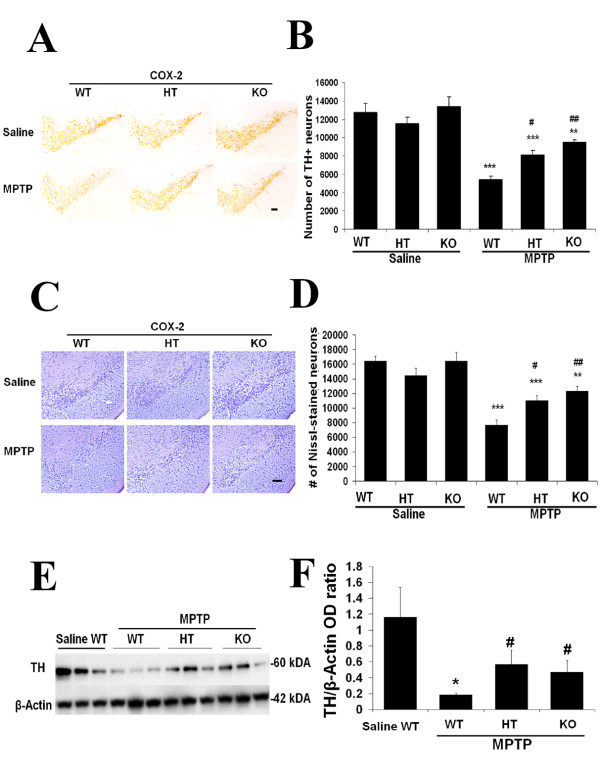
Ablation of COX-2 protects TH+ Neurons in SNpc from MPTP. A: In COX-2-/- (KO) mice, dopaminergic neurons are protected from MPTP neurotoxicity. Representative TH immunocytochemistry shows a marked loss of TH-positive neurons in SNpc of COX-2 +/+ (WT) mice compared to both COX-2 -/- (KO) and COX-2 +/- (HT) mice after MPTP treatment. B: MPTP treatment leads to a significant loss in number of TH+ neurons. TH-positive cells in the SNpc were bilaterally counted under 40 × objective. Nissl stain shows similar trends (C&D). E: COX-2 deficiency reduced the MPTP-induced loss of striatal TH immunoreactivity. F: MPTP-treated WT mice had significantly reduced TH immunoreactivity compared to the saline WT (*p < 0.05). Among the MPTP-treated mice, the COX-2-deficient mice had at least 30% higher TH immunoreactivity than the WT mice. Data are means ± SEM for six to eight mice per group, *p < 0.05, **p < 0.01 and ***p < 0.001 compared to saline+vehicle group; #p < 0.05 and ##p < 0.01 compared to MPTP+vehicle group, by ANOVA with subsequent Bonferroni for multiple comparisons. Scale bar, 100 μm.